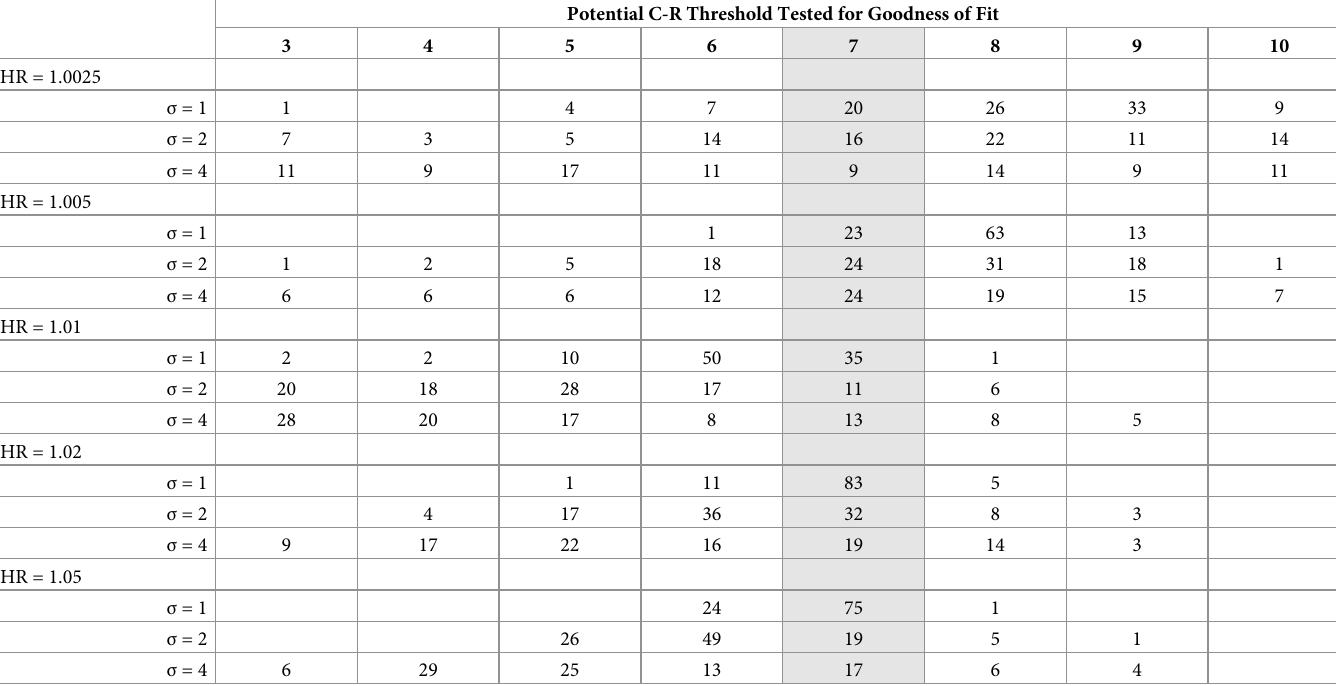
Table 2. Best-fitting C-R threshold level under varying amounts of measurement error, true threshold = 7. Potential C-R Threshold Tested for Goodness of